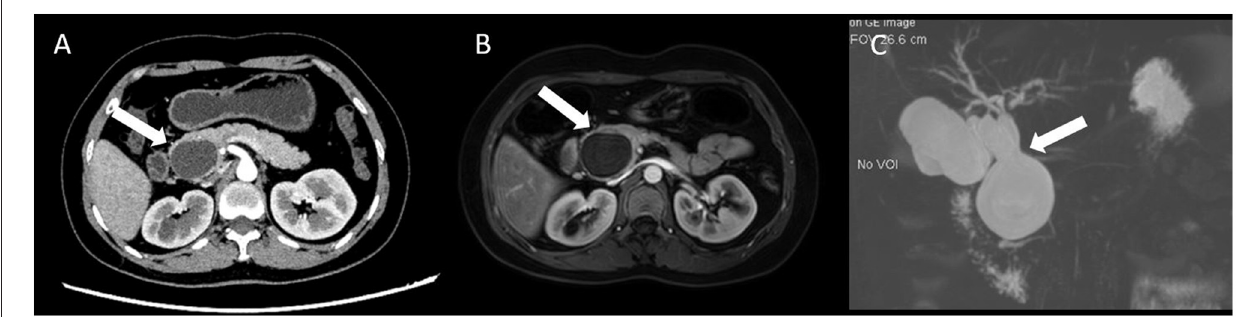
FIGURE 1 | Representative abdominal CT, MRI, and MRCP images. (A) CT scan showed a 4 × 3cm liquid dark area in the theoretical location of the pancreatic segment of the common bile duct, and the cystic wall showed no enhancement (white arrow); (B) MRI showed the spherical dilatation of the cystic dilatation (white arrow); and (C) Magnetic resonance cholangiopancreatography (MRCP) showed a probable choledochal cyst (white arrow).